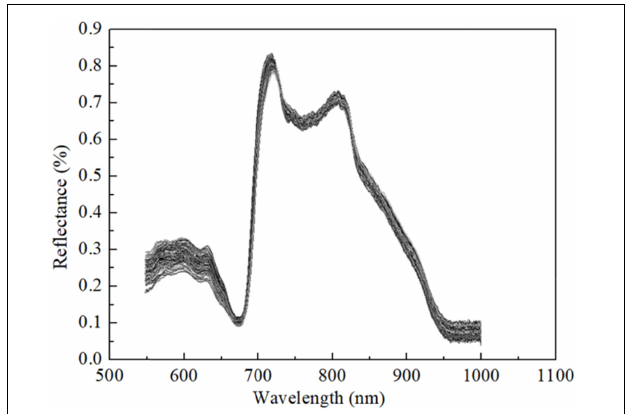
FIGURE 1 | Preprocessed spectral curves by SG-MSC.